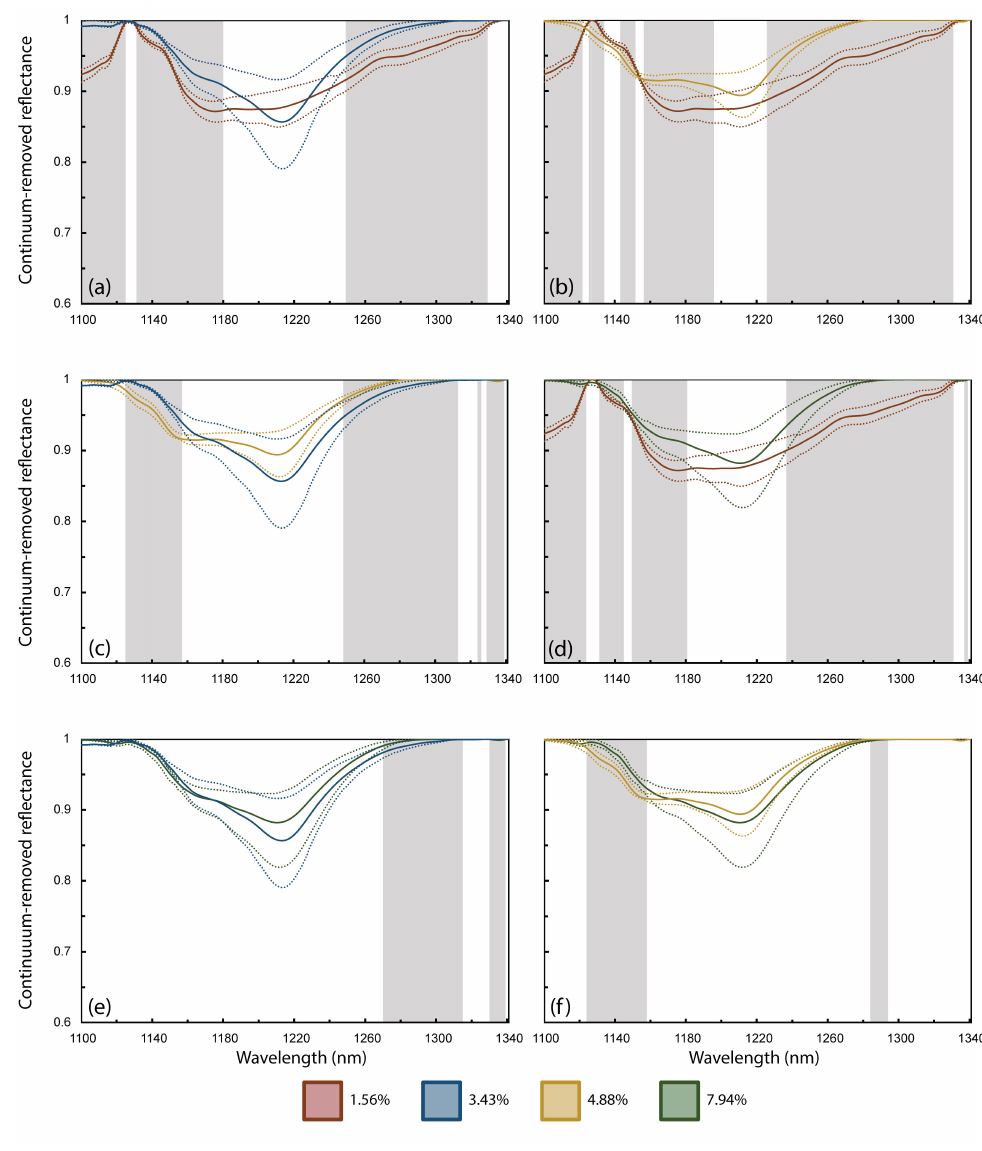
Figure 8. Continuum-removed reflectance of samples that were statistically different from sand spectra around 1215 nm, compared to each other. The mean and 95% upper and lower confidence intervals are shown for the MPD contaminated quadrats in each graph (in colour). Statistically significant differences are shaded in grey. Sample pairings are ( a ) 1.56% and 3.43% ( b ) 1.56% and 4.88% ( c ) 3.43% and 4.88% ( d ) 1.56% and 7.94% ( e ) 3.43% and 7.94% and ( f ) 4.88% and